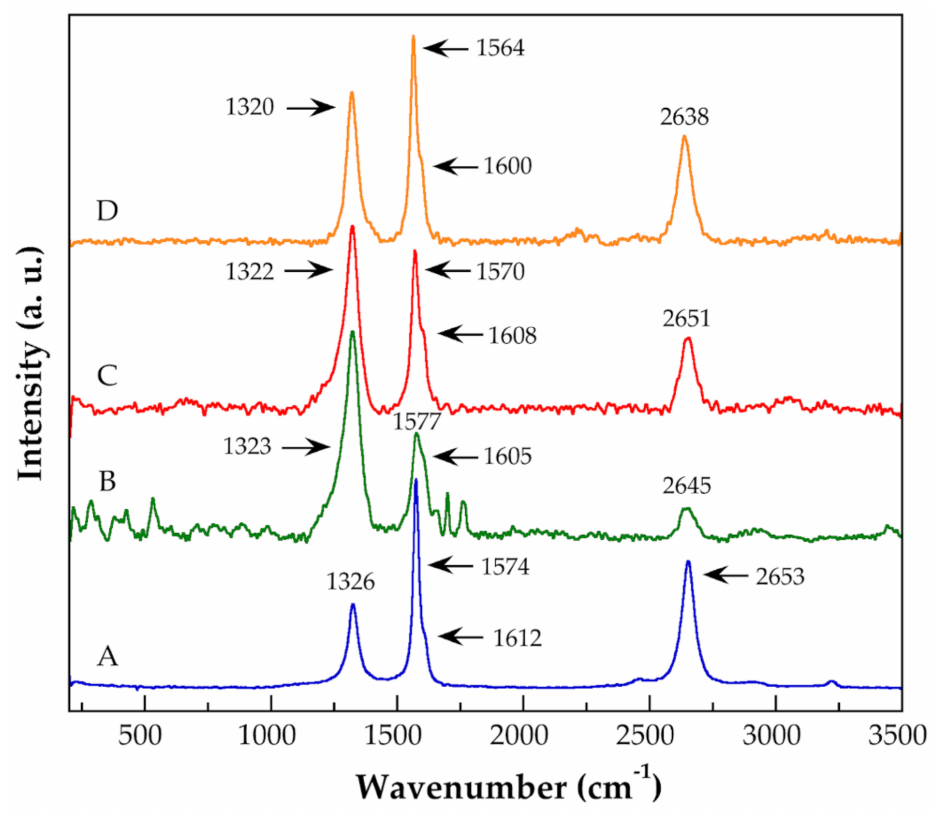
Figure 2. Raman spectra of CNTs o ( A ), CNTs r ( B ), CNTs o-OCl ( C ), and CNTs r-OCl ( D